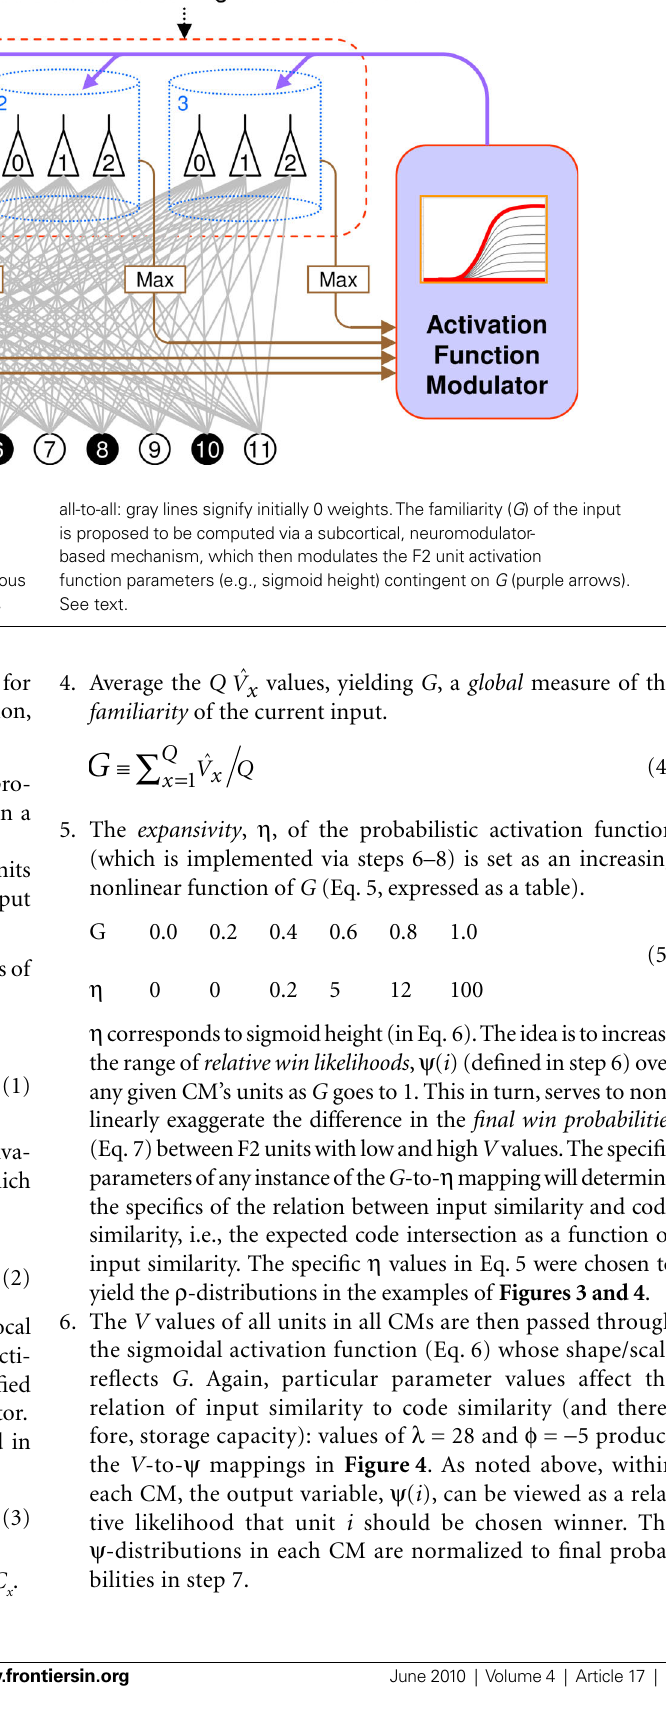
FIGURE 2 | Functional architecture. The input fi eld (F1) consists of binary feature detectors: a particular input consisting of fi ve active features is shown. The coding fi eld, F2, is proposed as a macrocolumn analog. It consists of winner-take-all competitive modules (CMs) proposed as analogous to minicolumns. Each CM has K = 3 binary units. Bottom-up connectivity is